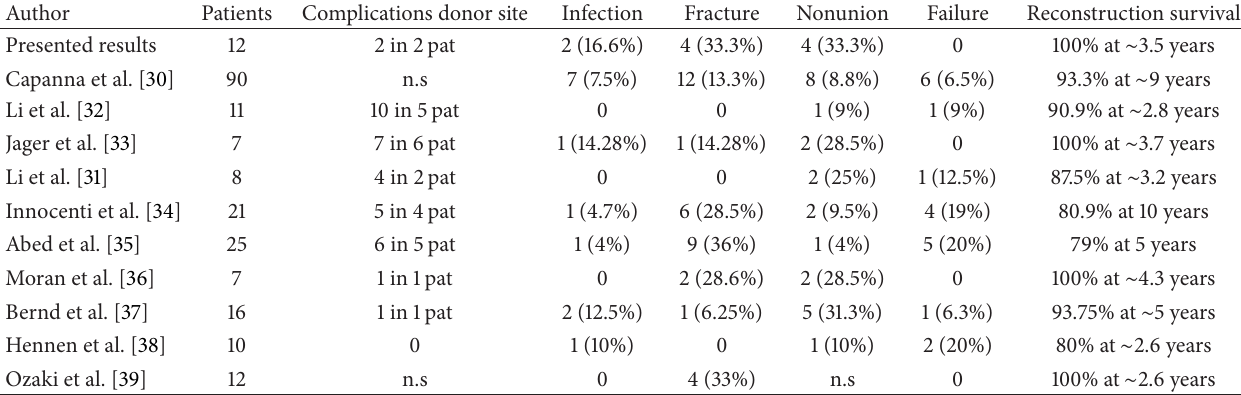
Table 2: Comparison of intercalary reconstructions with massive allograft and vascularised fibula in the lower